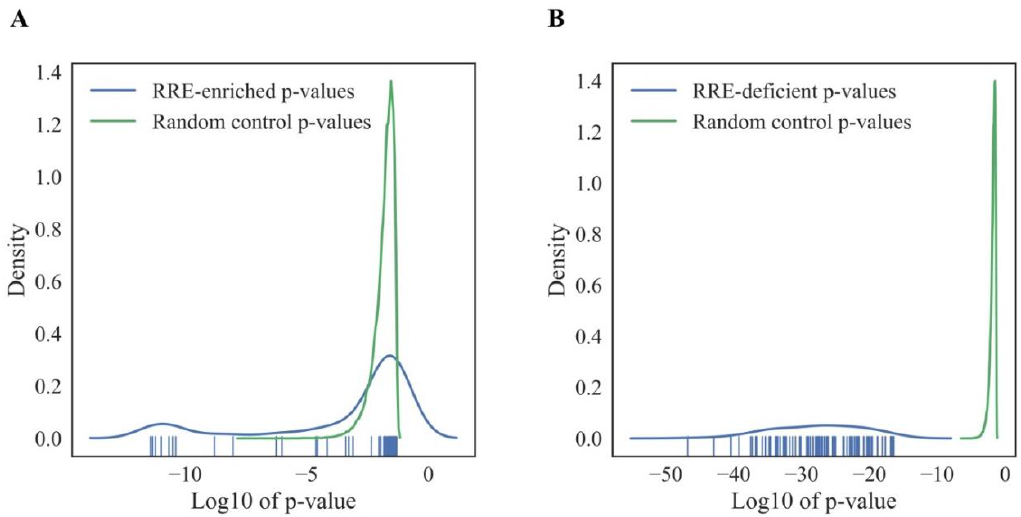
Figure 8. Random control of GO processes enrichment in RRE-enriched ( A ) and RRE-deficient ( B ) genes for all REs. for all